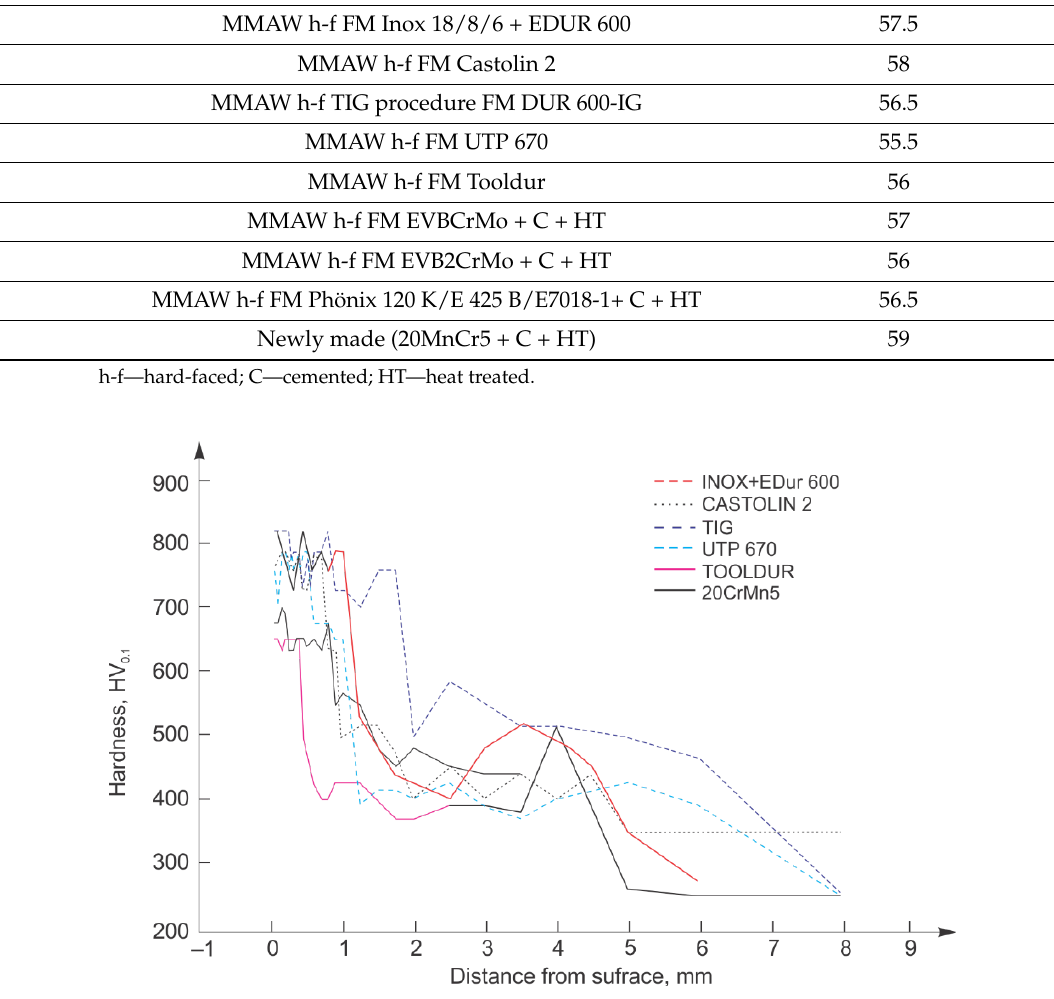
Table 5. Surface hardness and macrohardness of the hard-faced and newly made samples. Sample No.